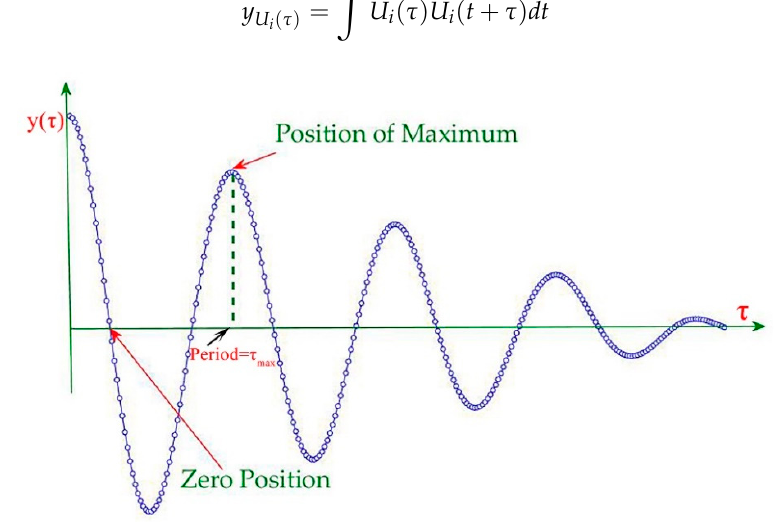
Figure 2. Period assessment of eigenvector via autocorrelation.